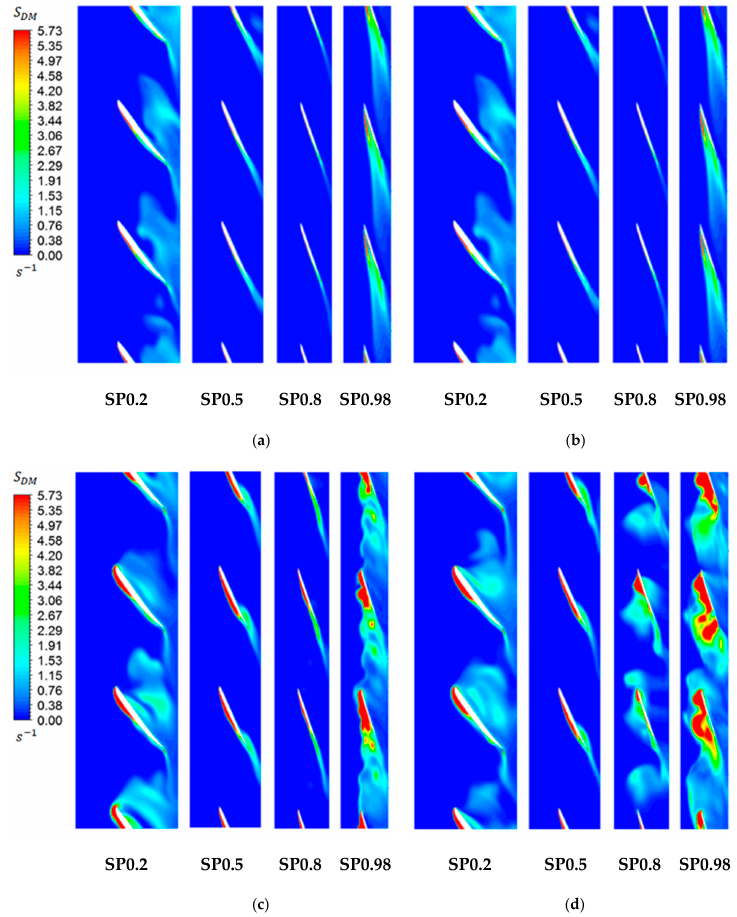
Figure 12. Distributions of S DM (reflecting the turbulent entropy generation rate) along di ff erent spans for the impeller with varying discharge (( a ) ϕ = 0.4; ( b ) ϕ = 0.354; ( c ) ϕ = 0.329; and ( d ) ϕ = 0.303 ) To explain the distributions of turbulent dissipation in the impeller, flow patterns around the blade suction side as presented by the iso-surface of TKE are investigated for four discharges. Figure 13 displays the iso-surface of TKE (for a value of 0.017) and iso-lines of non-dimensional TKE around the blade for varying discharge and a tip clearance of 0.1% span. It is seen that regions of high TKE (red areas in Figure 13) concentrated near the blade’s suction surface and the location of the tip leakage vortex near the shroud had high TKE under four discharges. Additionally, areas of high TKE,